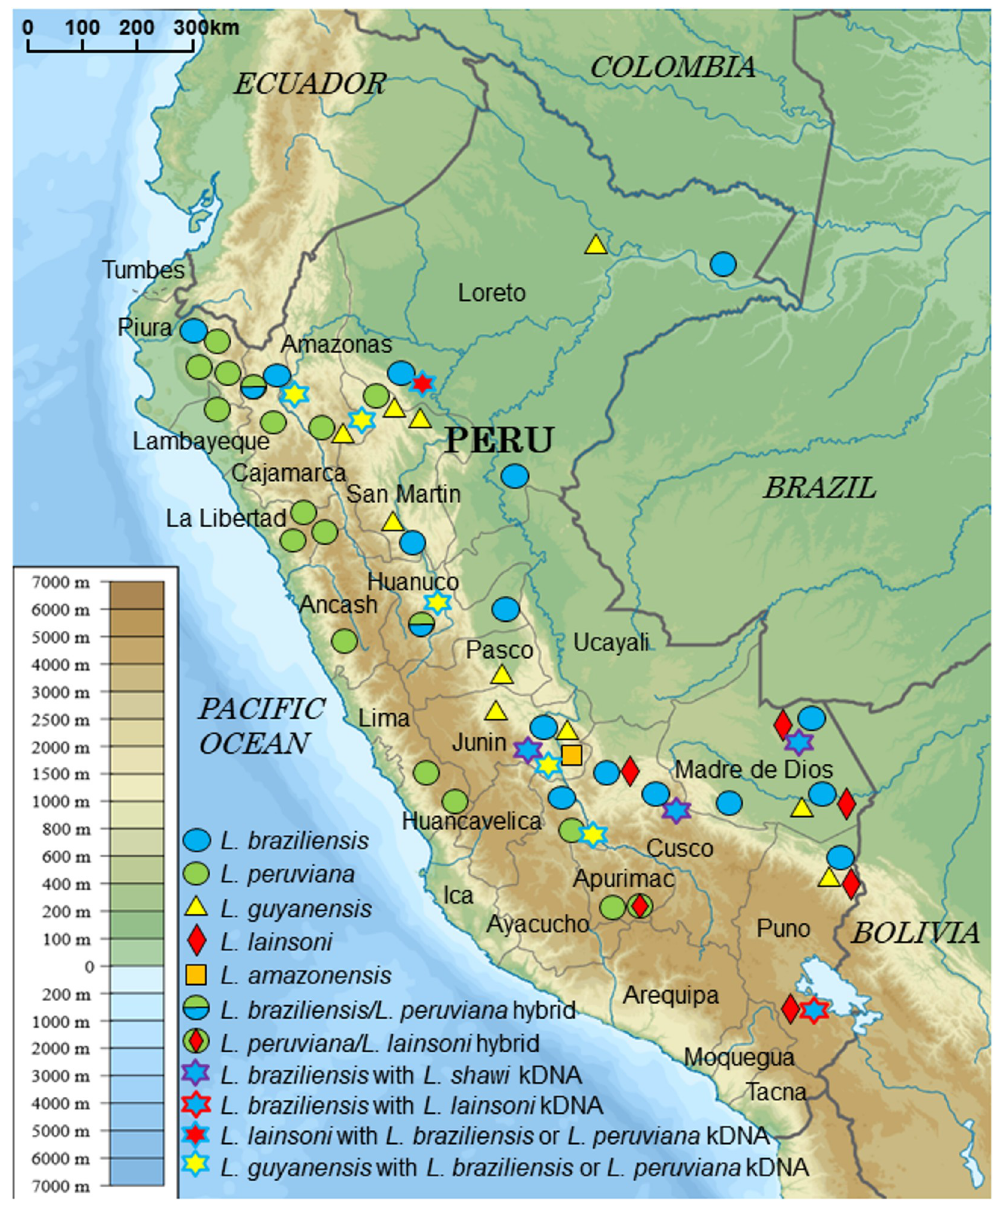
Fig 2. Geographic distribution of Leishmania species in Peru identified by PCR-RFLP of mpi and sequence analyses of kinetoplast and nuclear DNAs. (Adapted from a map available at https://commons.wikimedia.org/wiki/File%3APeru_